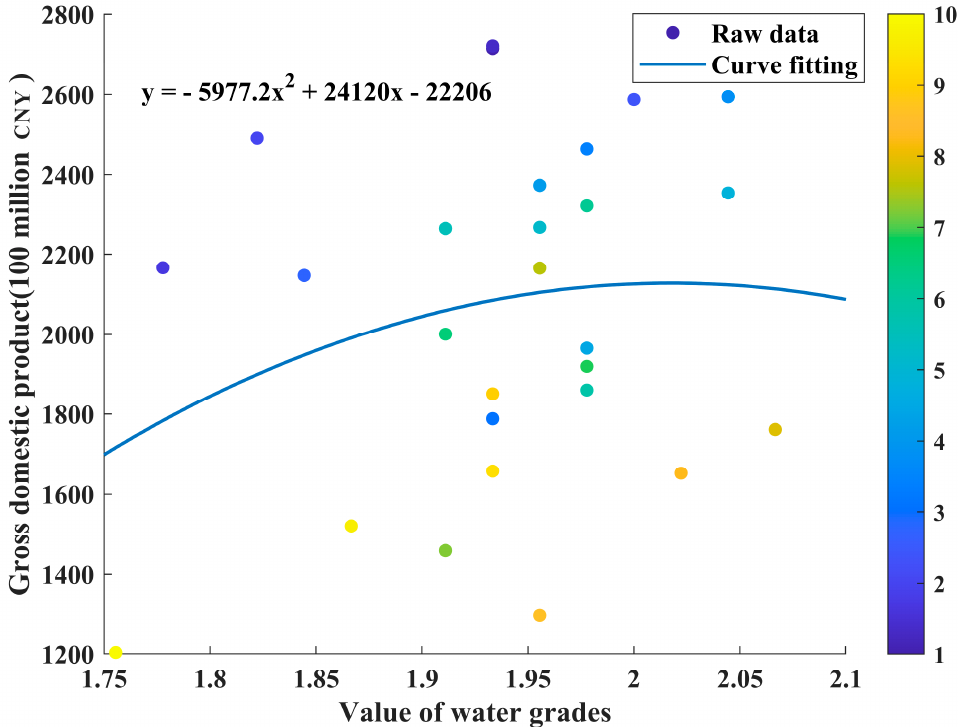
Figure 7. Relationship changes between water grades and GDP.